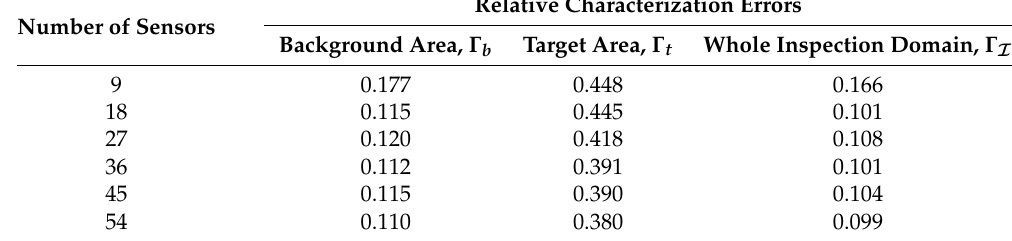
Table 4. Relative Errors on the Dielectric Characterization Versus the Number of Sensors.